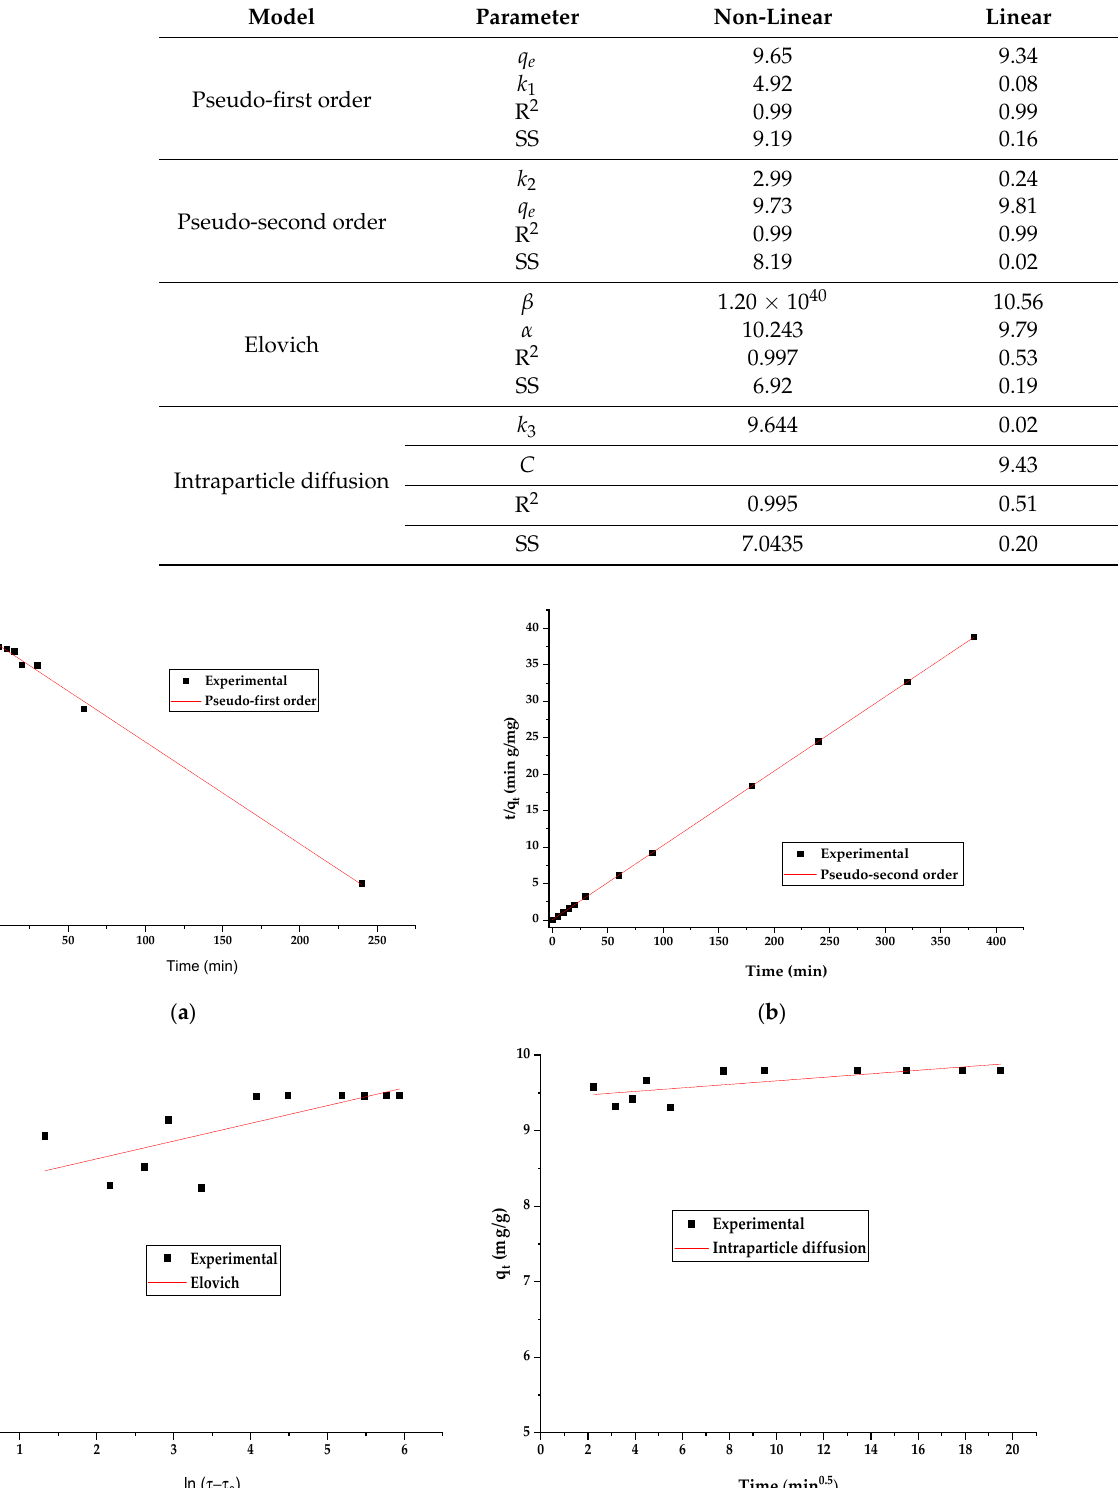
Table 6. Modeling adjustment parameters of Cr (VI) adsorption kinetics.